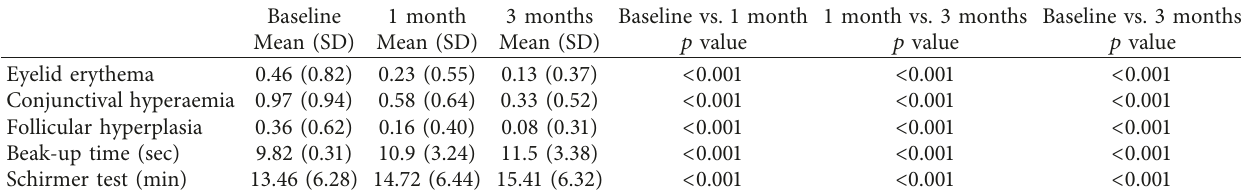
Table 2: Comparison of the data between baseline and the follow-up by using ANOVA test and the Bonferroni post hoc